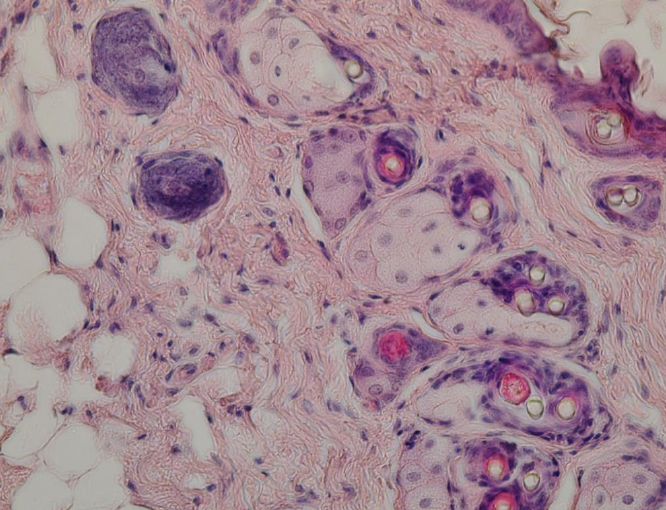
Figure 17. Multi-stem hair follicles in experimental group (stained with hematoxylin and eosin. Magnification ×400).